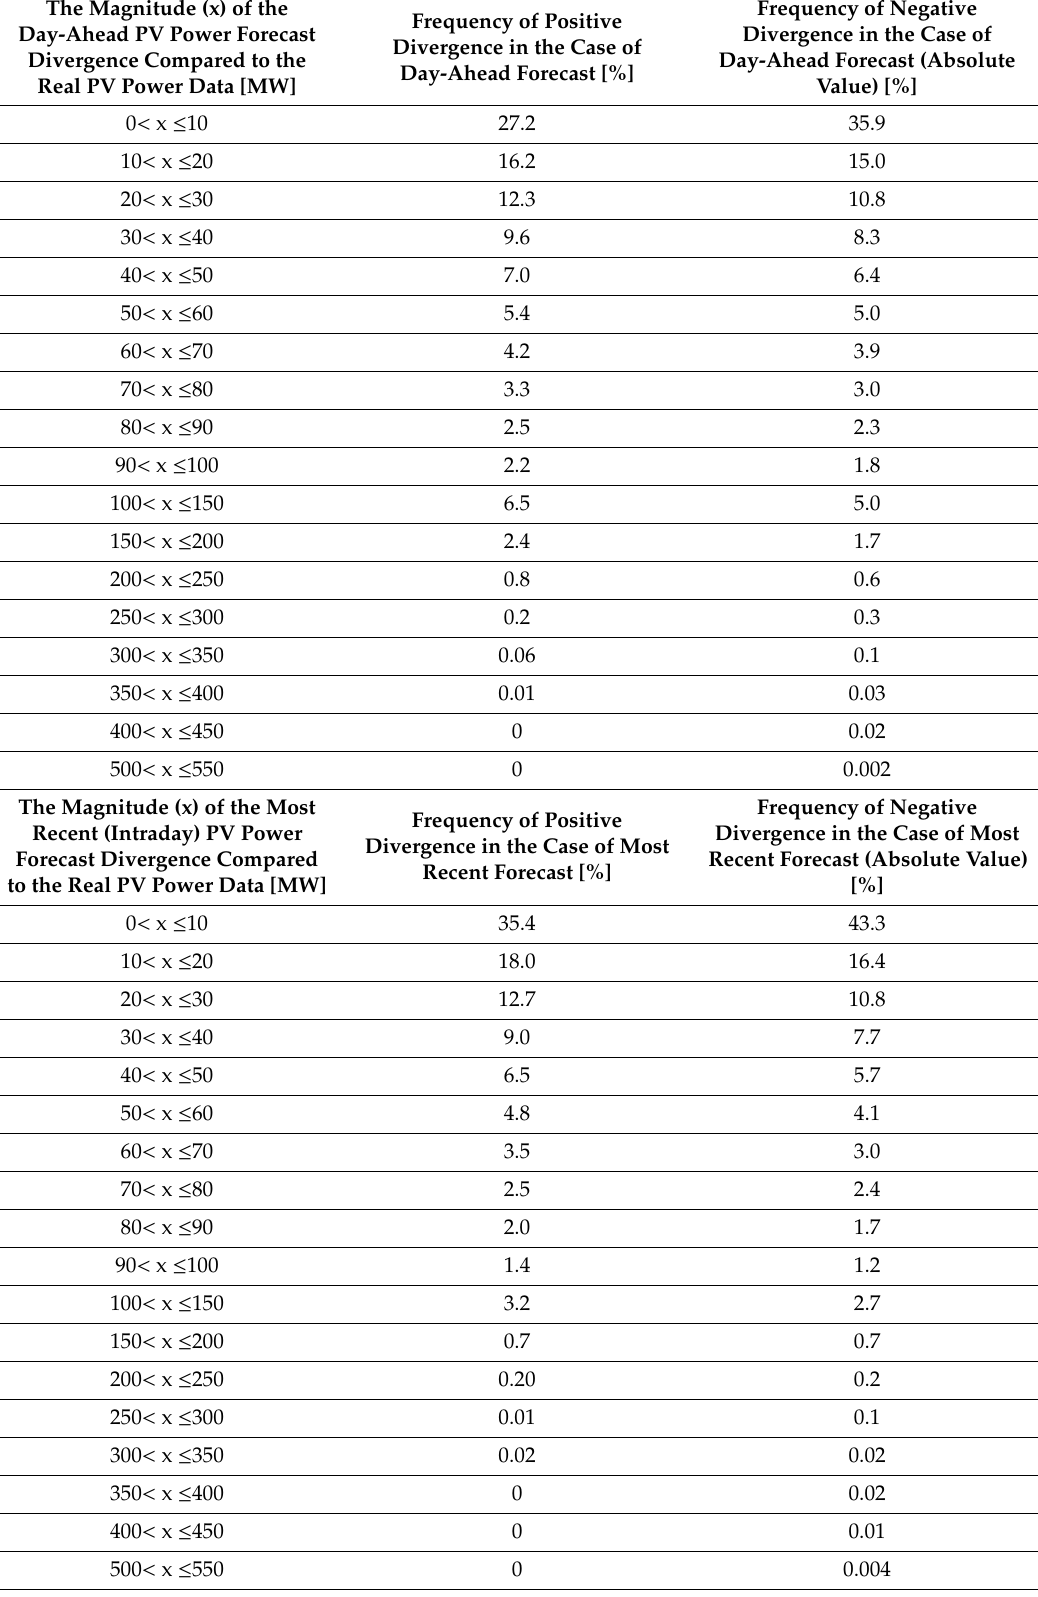
Table 4. Magnitudes of the day-ahead / intraday PV power forecast divergence (15 min-based) compared to the real PV power data for the period of 30 / 09 / 2014–30 / 09 /